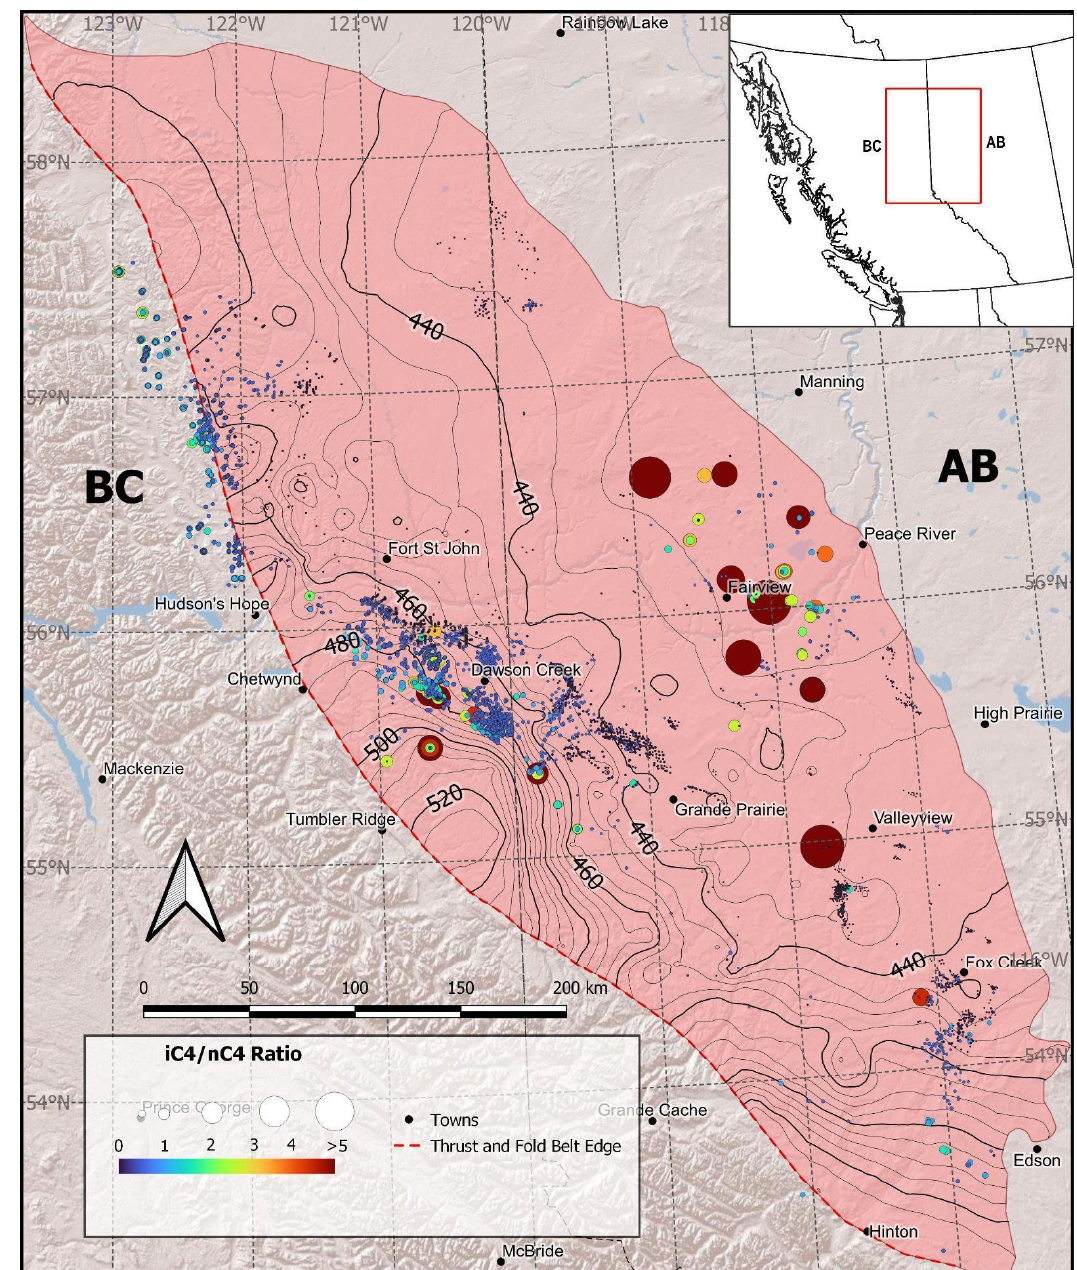
Figure 28. Distribution of thermal maturity in the Montney Formation and bubble map overlay of the iC4/nC4 ratio. In most cases, the ratio iC4/nC4 ratio increases towards the deformation front, as indicated by the symbols becoming larger and lighter blue and green colours. Ratios that are greater than 5 are probably anomalies and need to be further investigated.